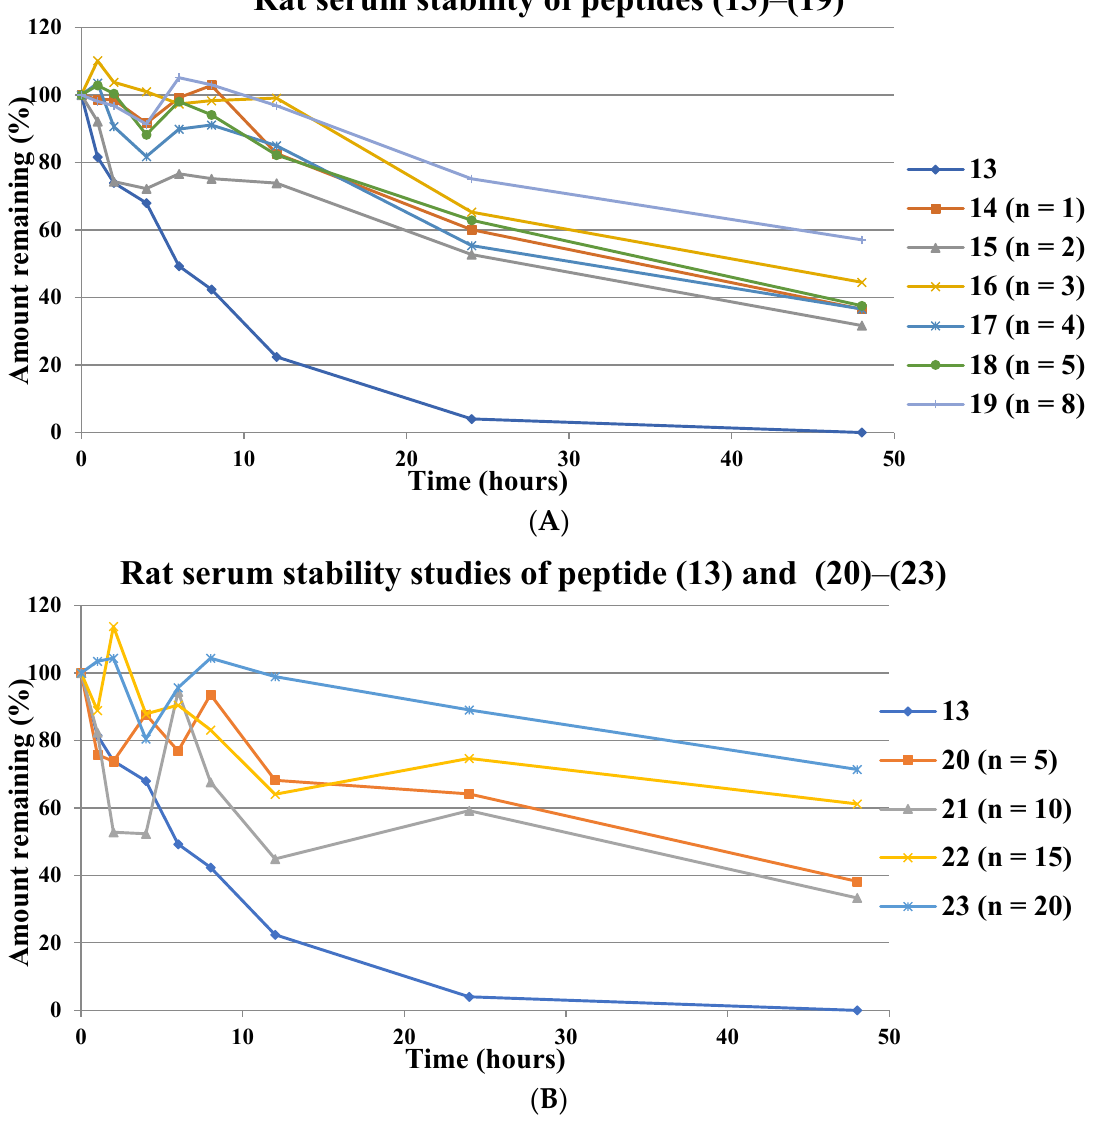
Figure 2. Detected levels (RP-HPLC) of A20FMDV2 ( 13 ) and PEGylated analogues ( 14 – 19 ), with ethylene glycol units attached via an acetyl handle ( A ) and propionyl handle ( B ), that remained over a period of 48 h in rat serum at 37 ◦ C; n = number of ethylene glycol units in the PEG chain. Data expressed as percentage of peptide remaining over a period of 48